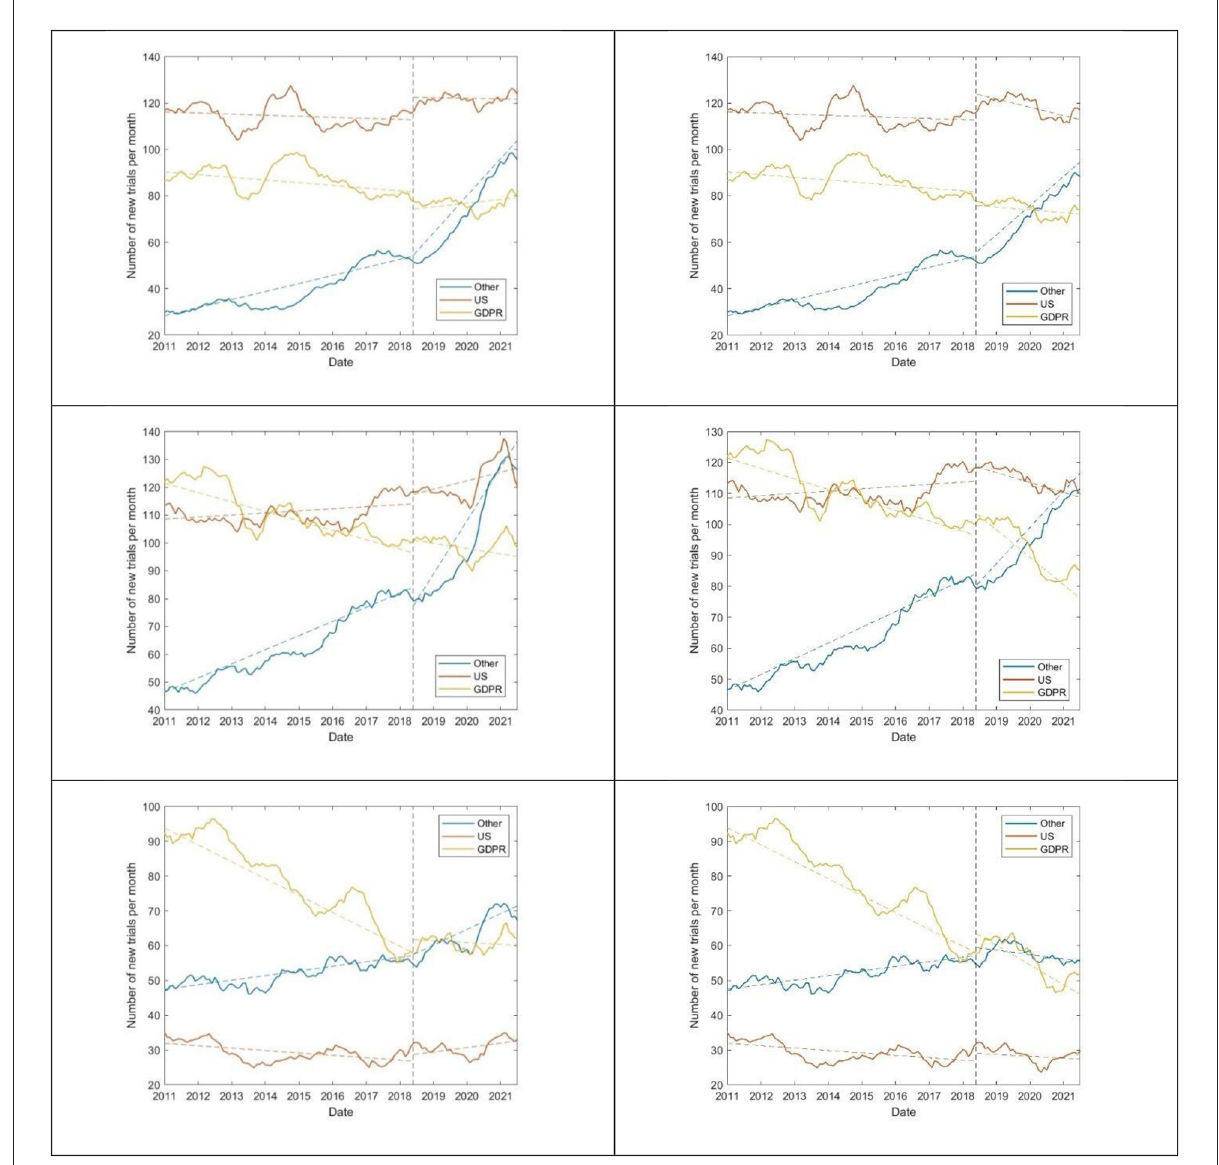
FIGURE1 Number of new phase 1 (top) , 2 (center) , and 3 (bottom) clinical trials registered on ClinicalTrials.gov per month by DPI status. Graphs on the left comprise all trials, while those on the right exclude COVID-19 trials. The vertical dotted line denotes the date of DPI. Colored dotted lines are linear regression lines fit to the